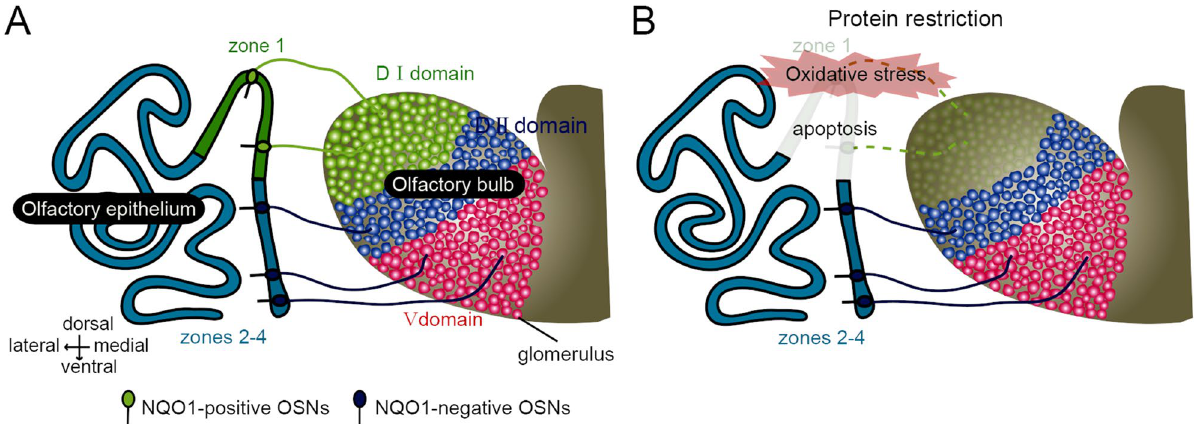
Figure 8. Schematic diagrams of olfactory information flow from OSNs to OB domains. ( A ) Mouse olfactory receptors (ORs) are divided into class I and class II receptors based on phylogenetic analysis. Class I OSNs expressing class I ORs are substantially distributed within zone 1 and mediate odor information to the dorsal domain of the OB (D I domain), whereas class II OSNs expressing class II ORs are distributed within zones 2–4, and mediate odor information to the dorsal domain of the OB (D II domain) and ventral domain of the OB (V domain). ( B ) Olfactory information flow from OSNs in zone 1 and zones 2–4 to OB domains under PR intervention. Under the PR intervention, oxidative stress occurred substantially in the NQO1-positive cells and induced zone 1-specific injury as apoptosis. Class I OSNs projecting to the D I domain are responsible for innate aversive behavior to odorants produced from spoiled foods. As a result, neural circuits mediating the induction of innate aversive behavior could be functionally